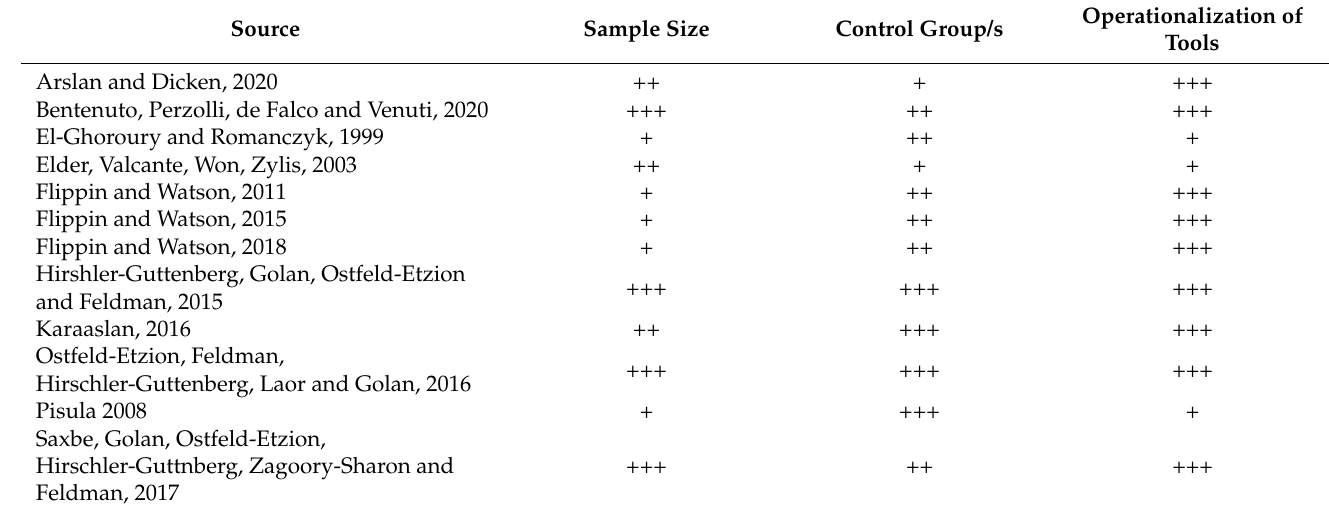
Table 1. Quality of the included studies in the systematic review.